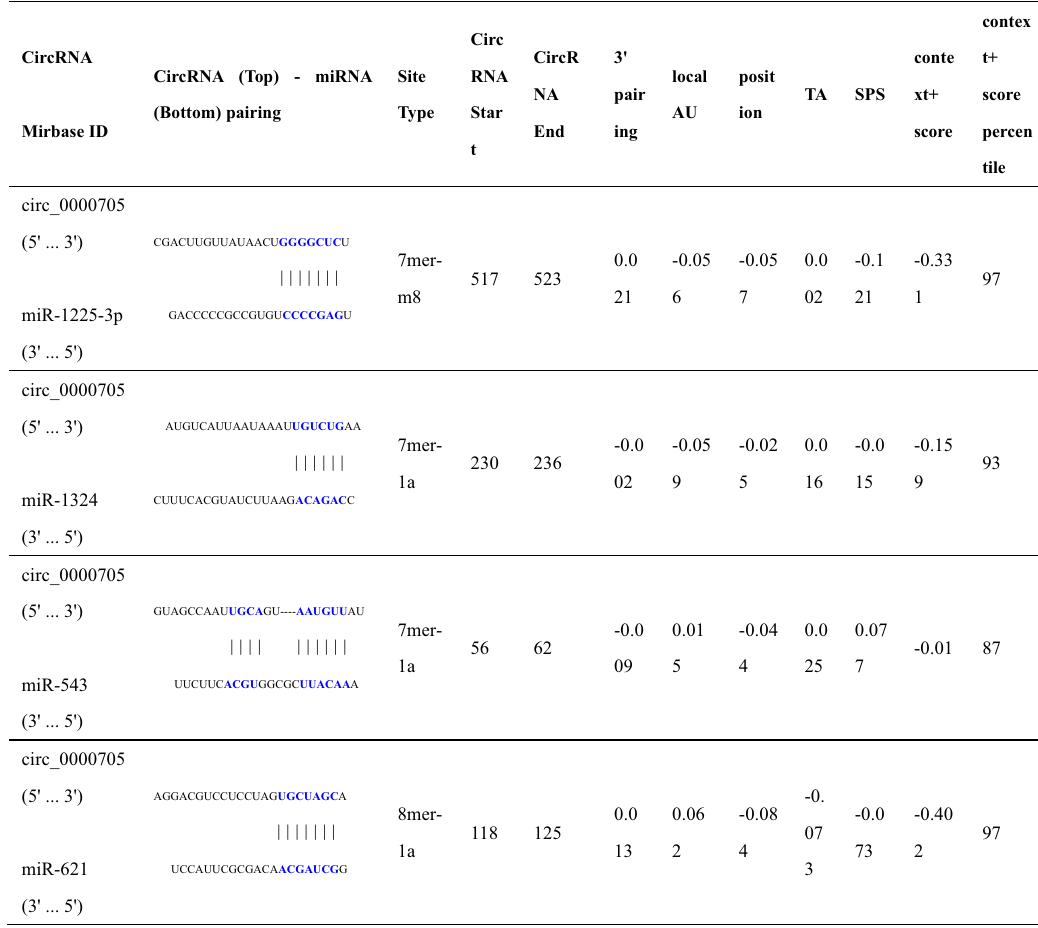
Table 3 Bioinformatics analysis of the binding between circ_0000705 and the predicted miRNAs